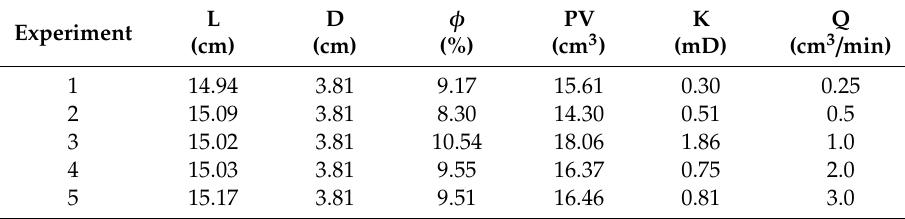
Figure 13. S chematic of the linear coreflooding system. Figure 13. Schematic of the linear coreflooding system. Table 5. Routine properties of the core samples used for coreflooding at 250 ◦ F and 1000 psi back pressure at di ff erent injection rates